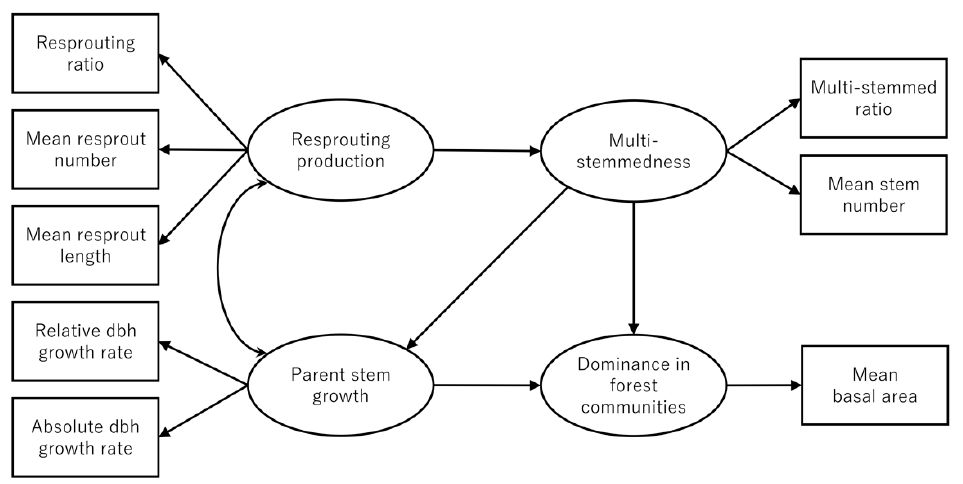
Figure 2. Hypothetical relationships among resprout production, parent stem growth, multi-stemmedness, and dominance in forest communities.